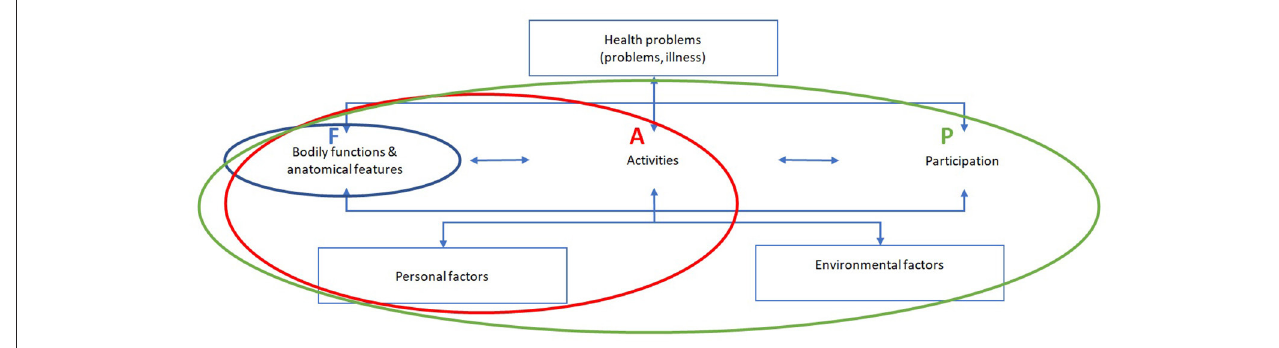
FIGURE 2 | Differences in the purpose of care regarding RTW for cancer patients based on the ICF model.